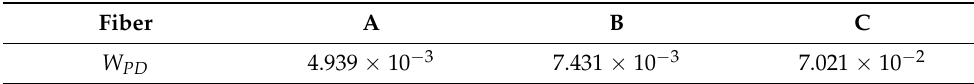
Table 4. The average value of 𝑊 𝑃𝐷 of optical Fibers A — C.